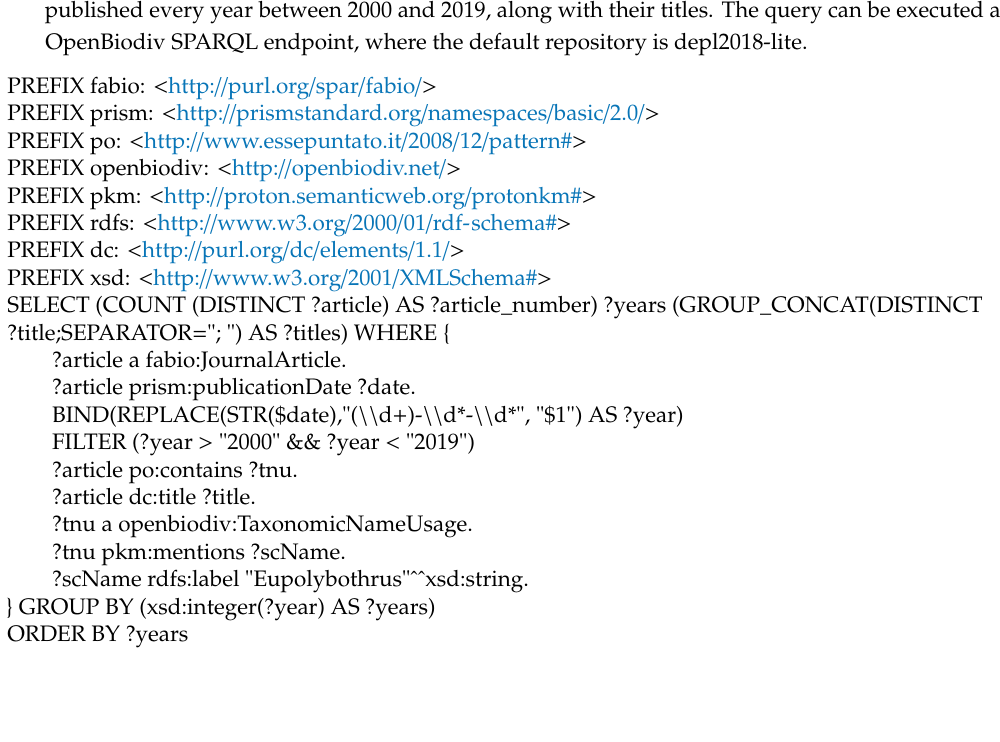
Table A1. A SPARQL query to retrieve the number of articles about Eupolybothrus which have been published every year between 2000 and 2019, along with their titles. The query can be executed at